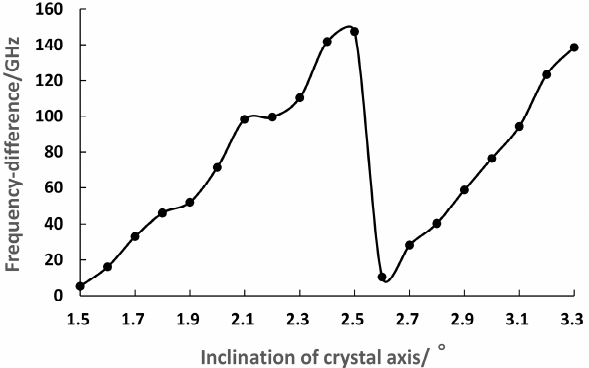
Figure 30. Relationship between frequency difference and tilt angle of the BC 1 [36].